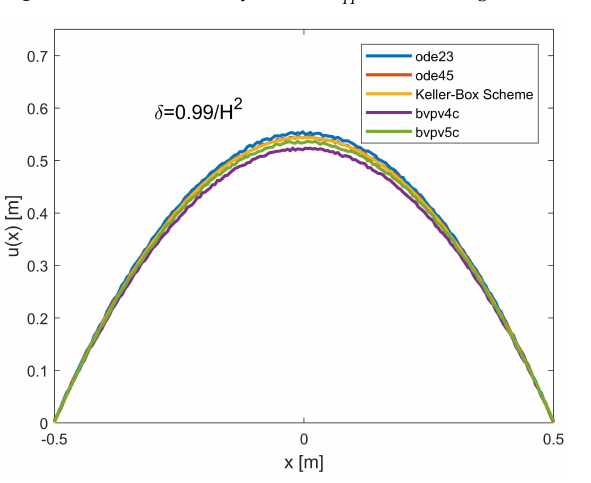
(in convergence conditions and without ghost solutions). H 2